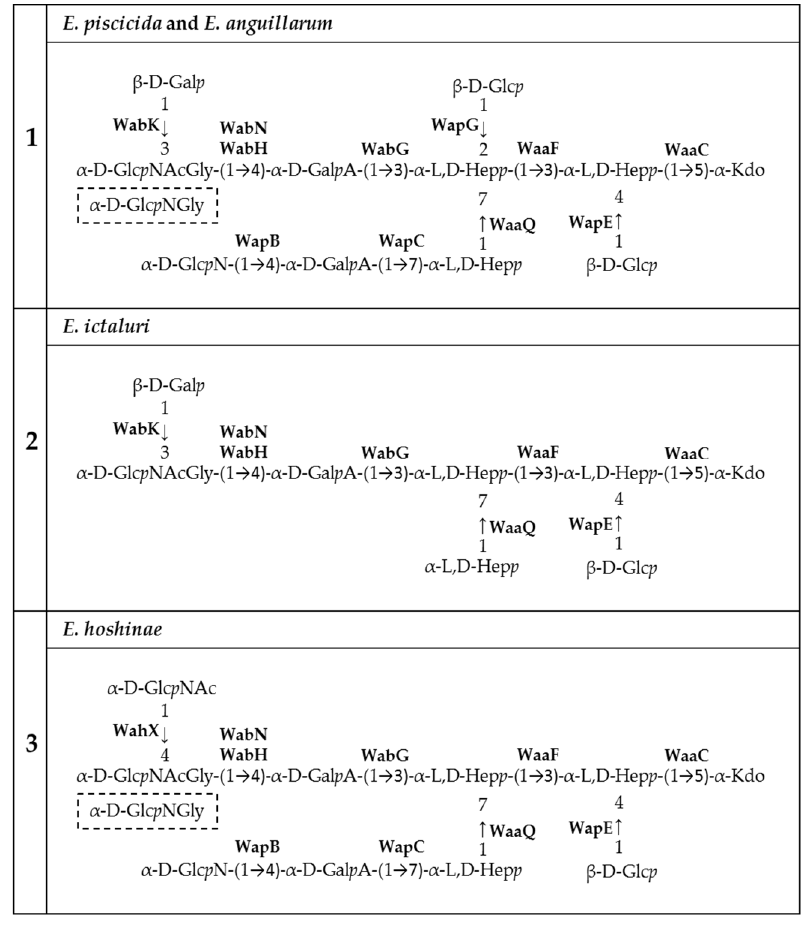
Figure 9. ( 1 ) Chemical structure of the core oligosaccharide of E. piscicida HL9.1 and E. anguillarum 205/03, ( 2 ) E. ictaluri AL ‐ 15 ‐ 01 ‐ CATFISH, and ( 3 ) E. hoshinae DSMZ 13771 T with presumptive assignment of genes involved in its biosynthesis.